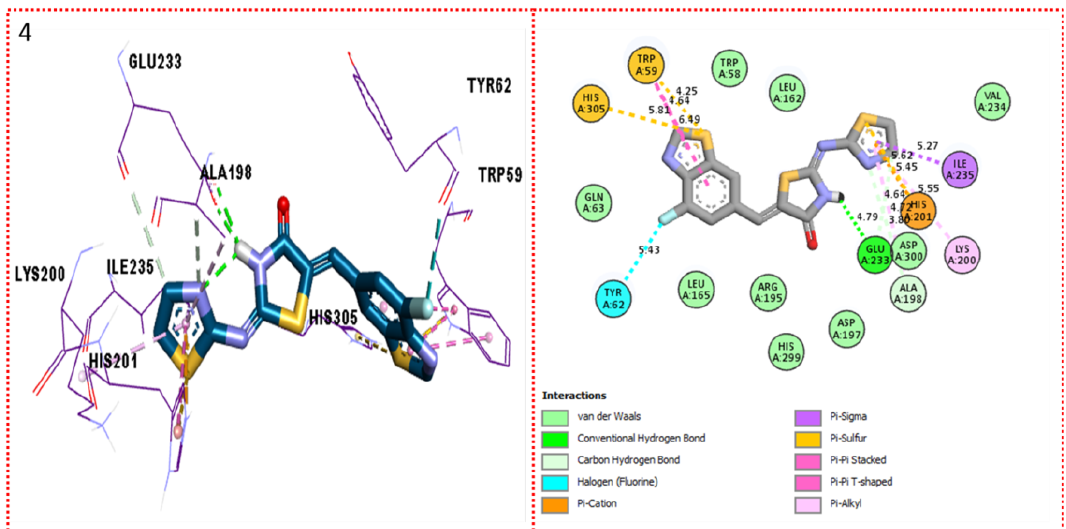
Figure 7. Protein – ligand interaction profile for active analogue against α‐ amylase represents the surface of the corresponding enzyme and indicates the PLI profile for compound 4 .